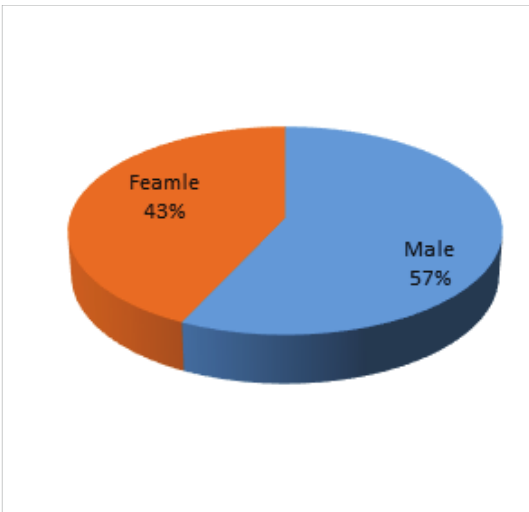
Figure 1: Distribution of patients according to the gender.